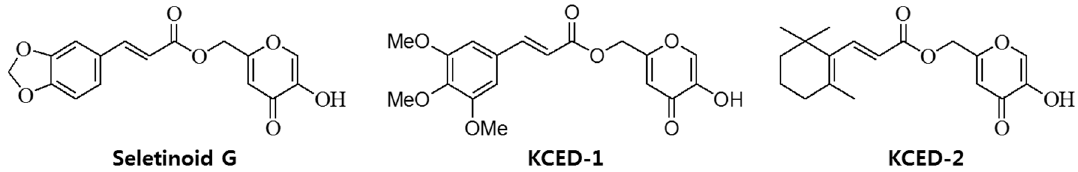
Figure 1. The structures of the kojyl cinnamate ester derivatives Seletinoid G, KCED-1, and KCED-2.